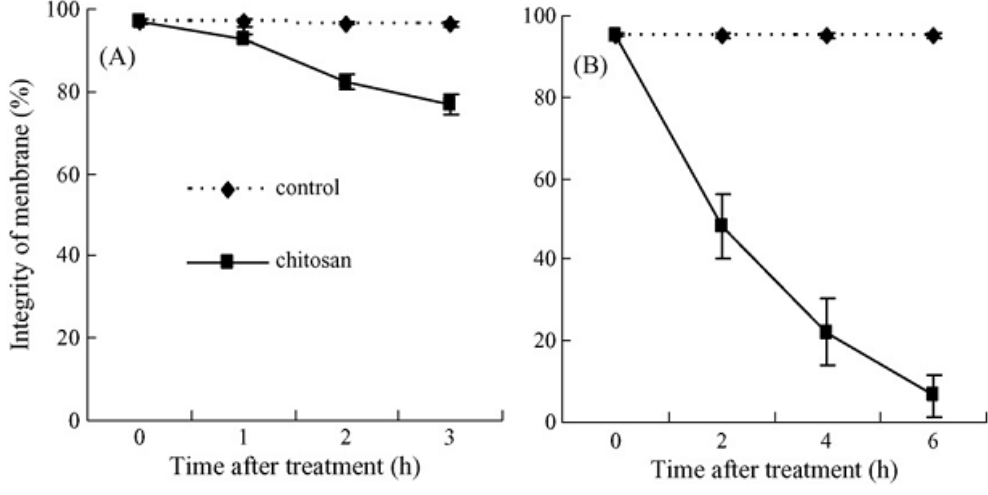
Figure 10. Effects of chitosan on plasma membrane integrity of the spores of B. cinerea ( A ) and P. expansum ( B ). Pathogen spores were cultured in PDB containing 5% chitosan or in PDB without chitosan as the control at 25 °C. Bars represent standard deviations of the means. Reproduced from Reference